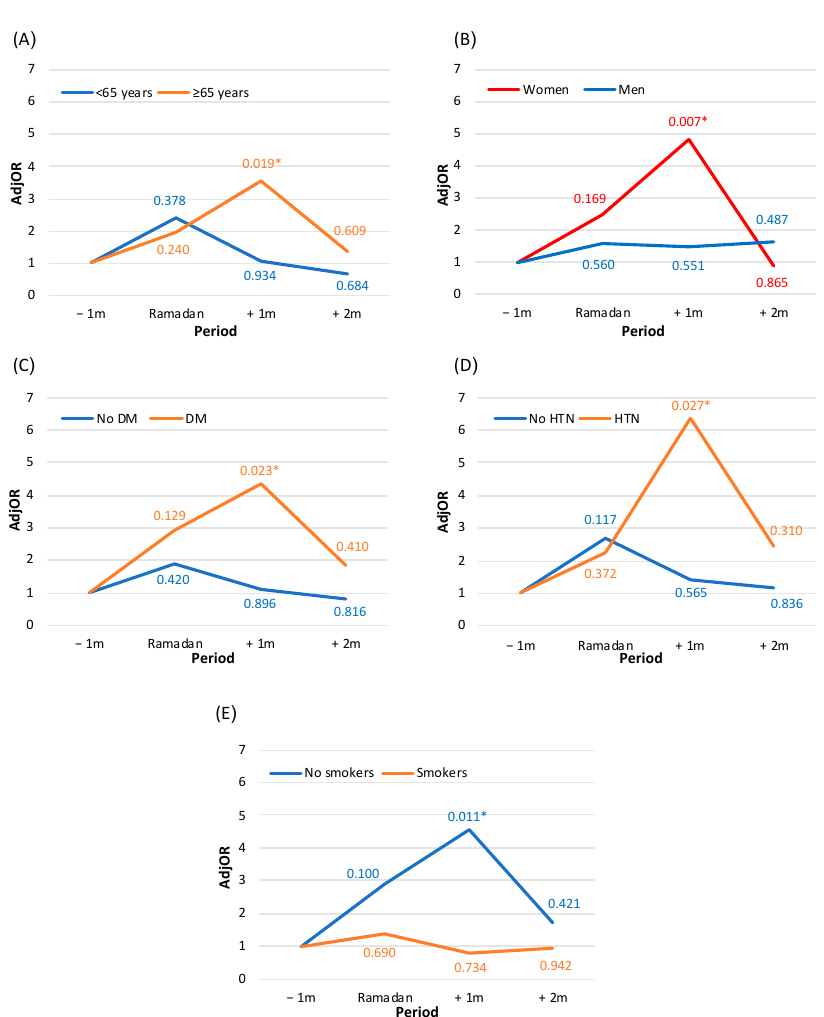
Figure 3. Relative risk for one-month mortality by study period among Muslims: subgroup analysis by ( A ) age, ( B ) sex, ( C ) diabetes mellitus (DM), ( D ) hypertension (HTN), and ( E ) smoking status. The figure presents the results of the multivariate models (separate model for each panel). Each model is adjusted for: year of the event, age, type of acute myocardial infarction, left ventricular dysfunction, chronic ischemic heart disease, renal diseases, anemia, and gastrointestinal bleeding. The numbers present p -values of adjusted odds ratios (AdjOR) compared to the period of one-month prior to Ramadan. *—statistically significant interaction ( p -for-interaction < 0.05). Legend: − 1 m—month prior to